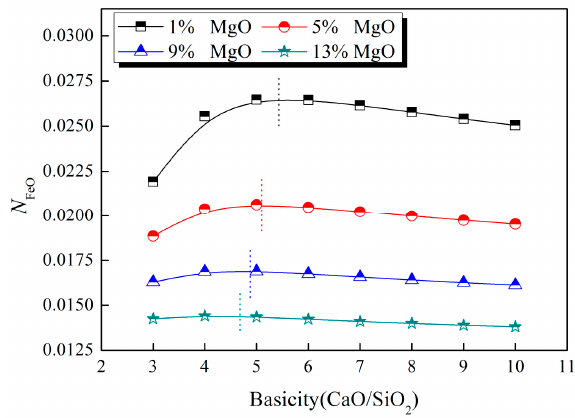
Figure 3. Effect of MgO content on the optimal alkalinity.